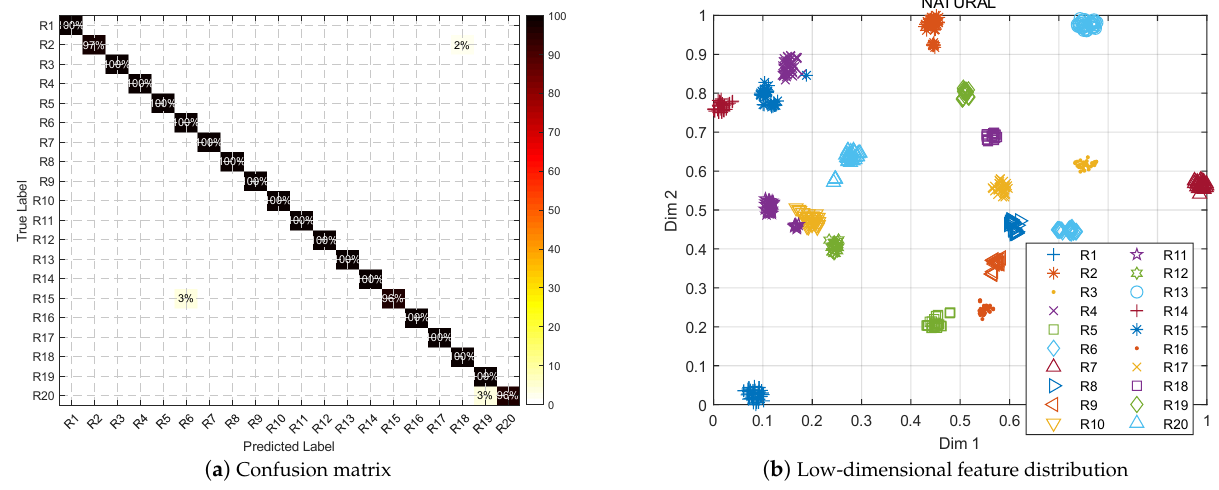
Figure 9. Identification performance and the feature distribution of directly trained DNN for Dataset 1. The average identification accuracy is P =